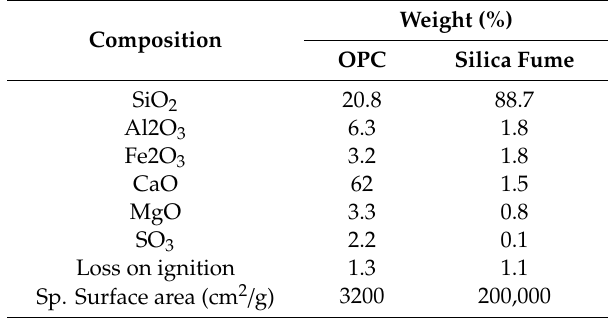
Table 1. Chemical composition and physical properties of OPC and silica fume.